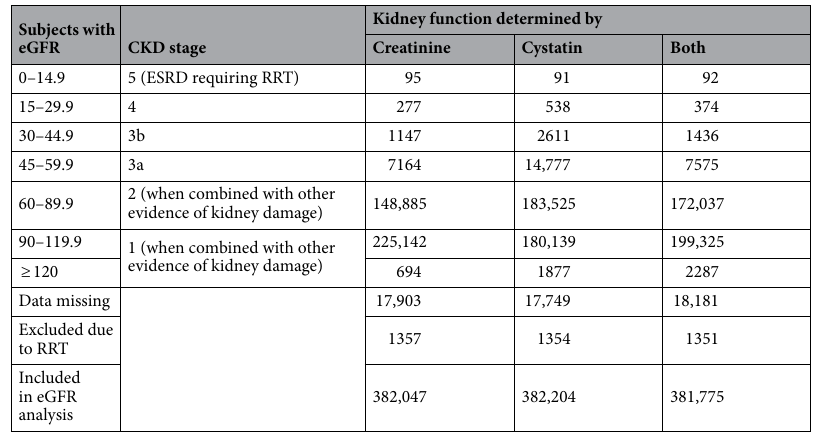
Table 2. Distribution of subjects’ eGFR. This shows the distribution of subjects’ eGFRs for each of the three eGFR formulae, as well as the number of subjects included and excluded. eGFR thresholds are based on thresholds used for CKD diagnosis. Some subjects were dependent on RRT so were not included in analysis of eGFR, though their eGFRs are included in this table.